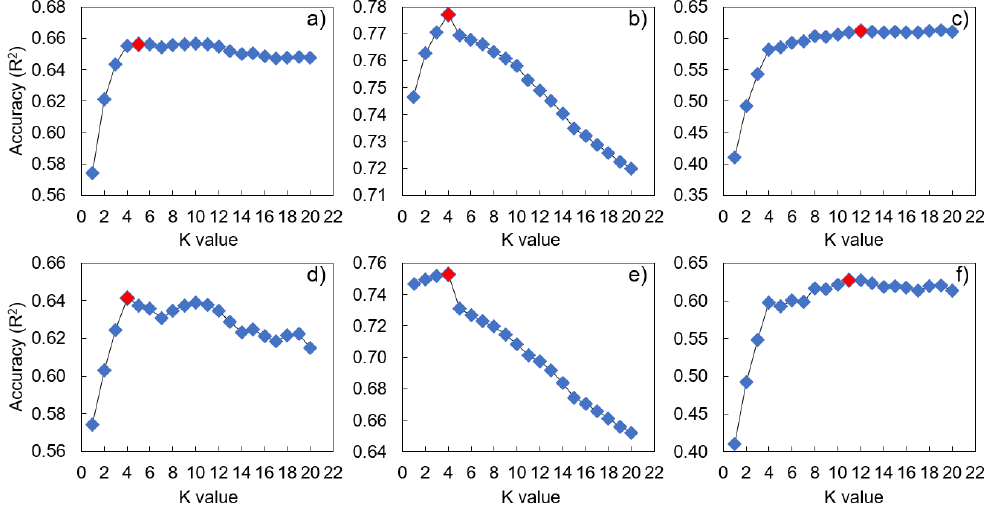
number of samples for each leaf; Max depth: the maximum tree depth.